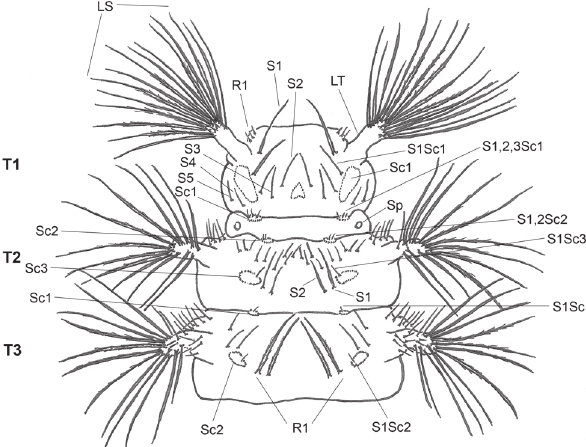
Figura 6. Tórax do terceiro instar de C. caligata , vista dorsal. (LS) Cerda no tubérculo lateral, (LT) tubérculo lateral, (R1) fileira de cerdas, (Scx) esclerito, (Sp) espiráculo, (Sx) cerda, (SxScx) cerda associada ao esclerito, (T1) protórax, (T2) mesotórax, (T3)